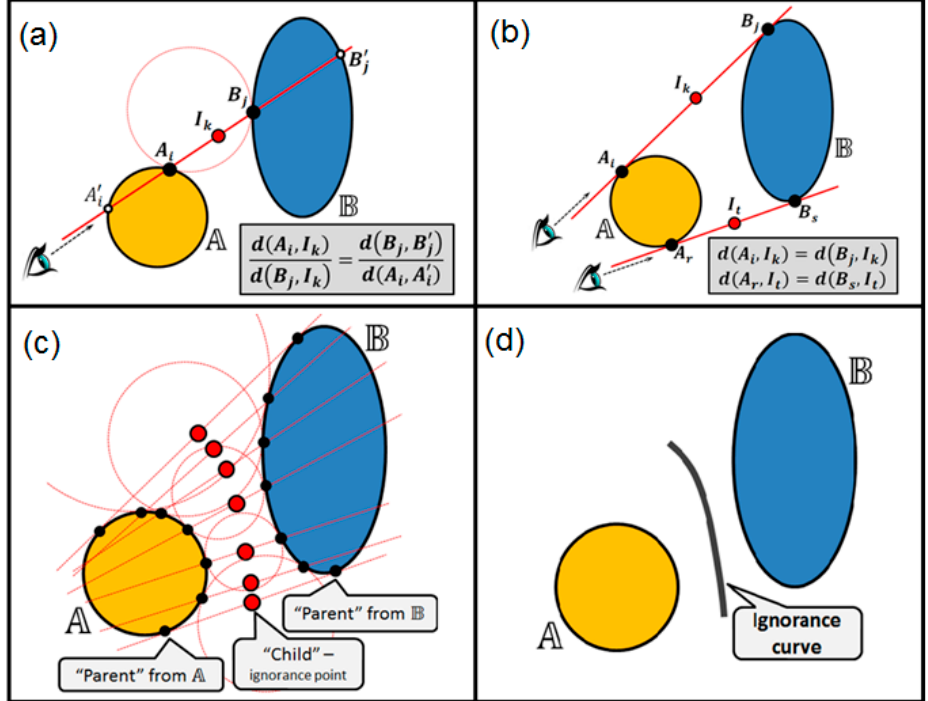
Figure 7. Illustration of the ignorance (decision boundary) curve discovery with the Balanced View method: ( a ) “Balance” equation for each pair of “parents”; ( b ) computing locations for the ends of the ignorance curve; ( c ) computing locations for the “children” of all pairs of “parents”; ( d ) visualizing the resulting ignorance curve. One may see here how the actual shapes of the manifolds influence the curve shape.